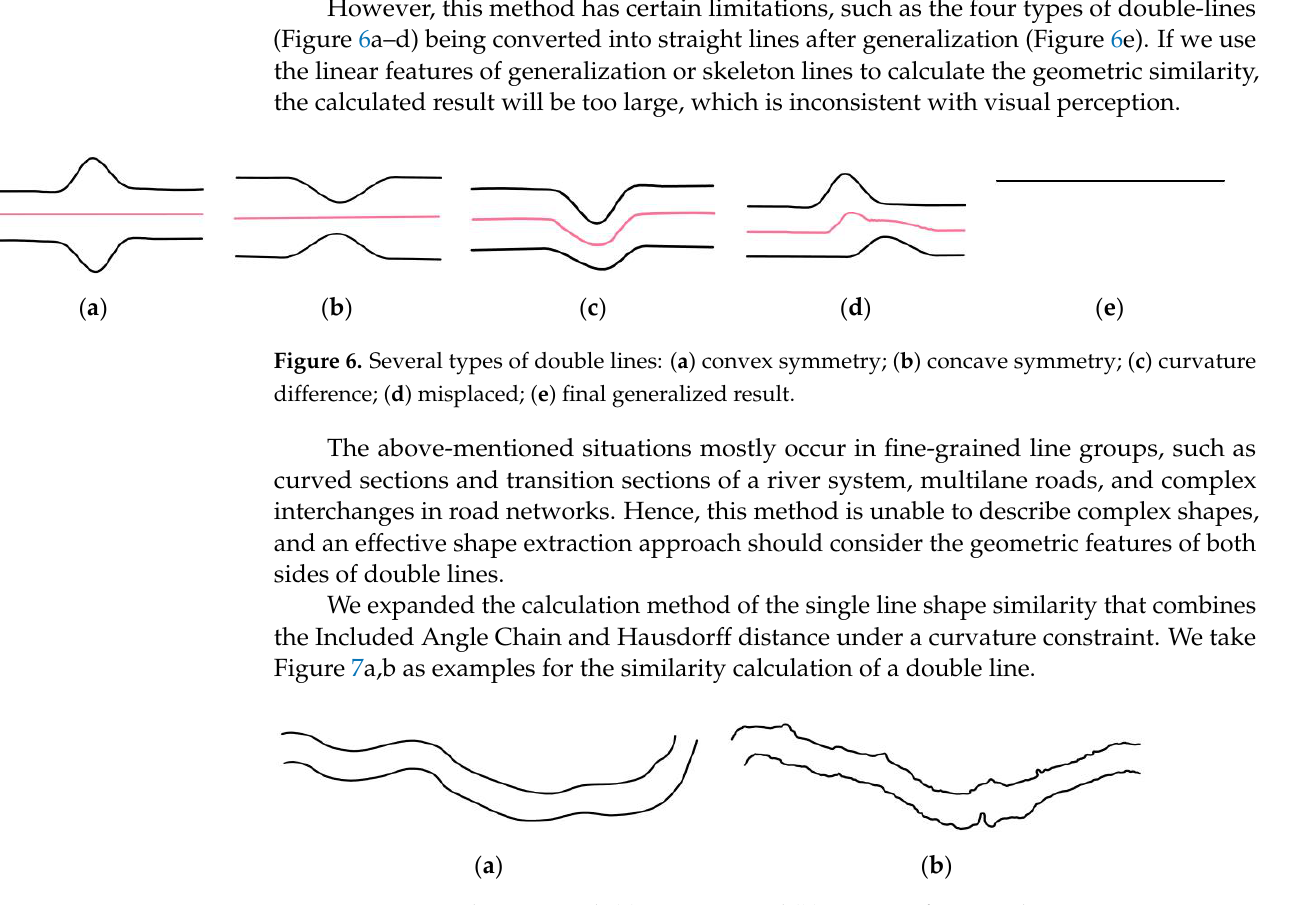
is the similarity A ( C (cid:24)(cid:23) ) , B ( C (cid:24)(cid:23) )